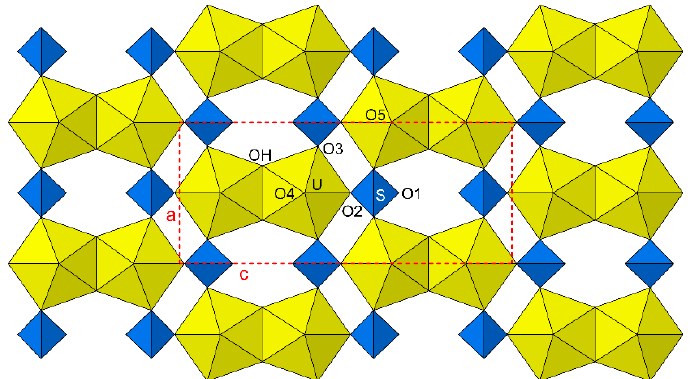
Figure 5. The uranyl-sulfate sheet in the structure of chenowethite viewed down [010]. The unit cell outline is shown by dashed red lines with cell directions labeled in red.